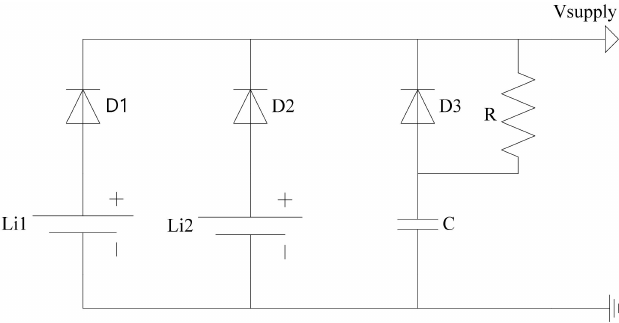
Figure 5. Schematic diagram of power